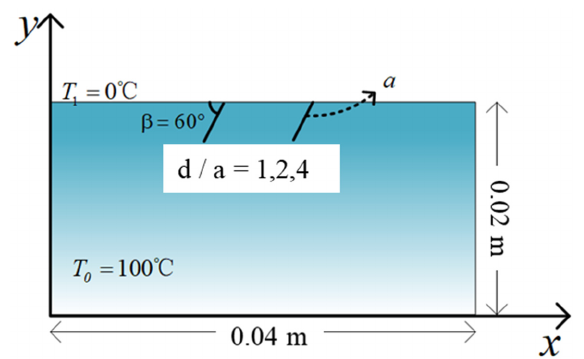
Figure 19. Boundary conditions for double cracks.